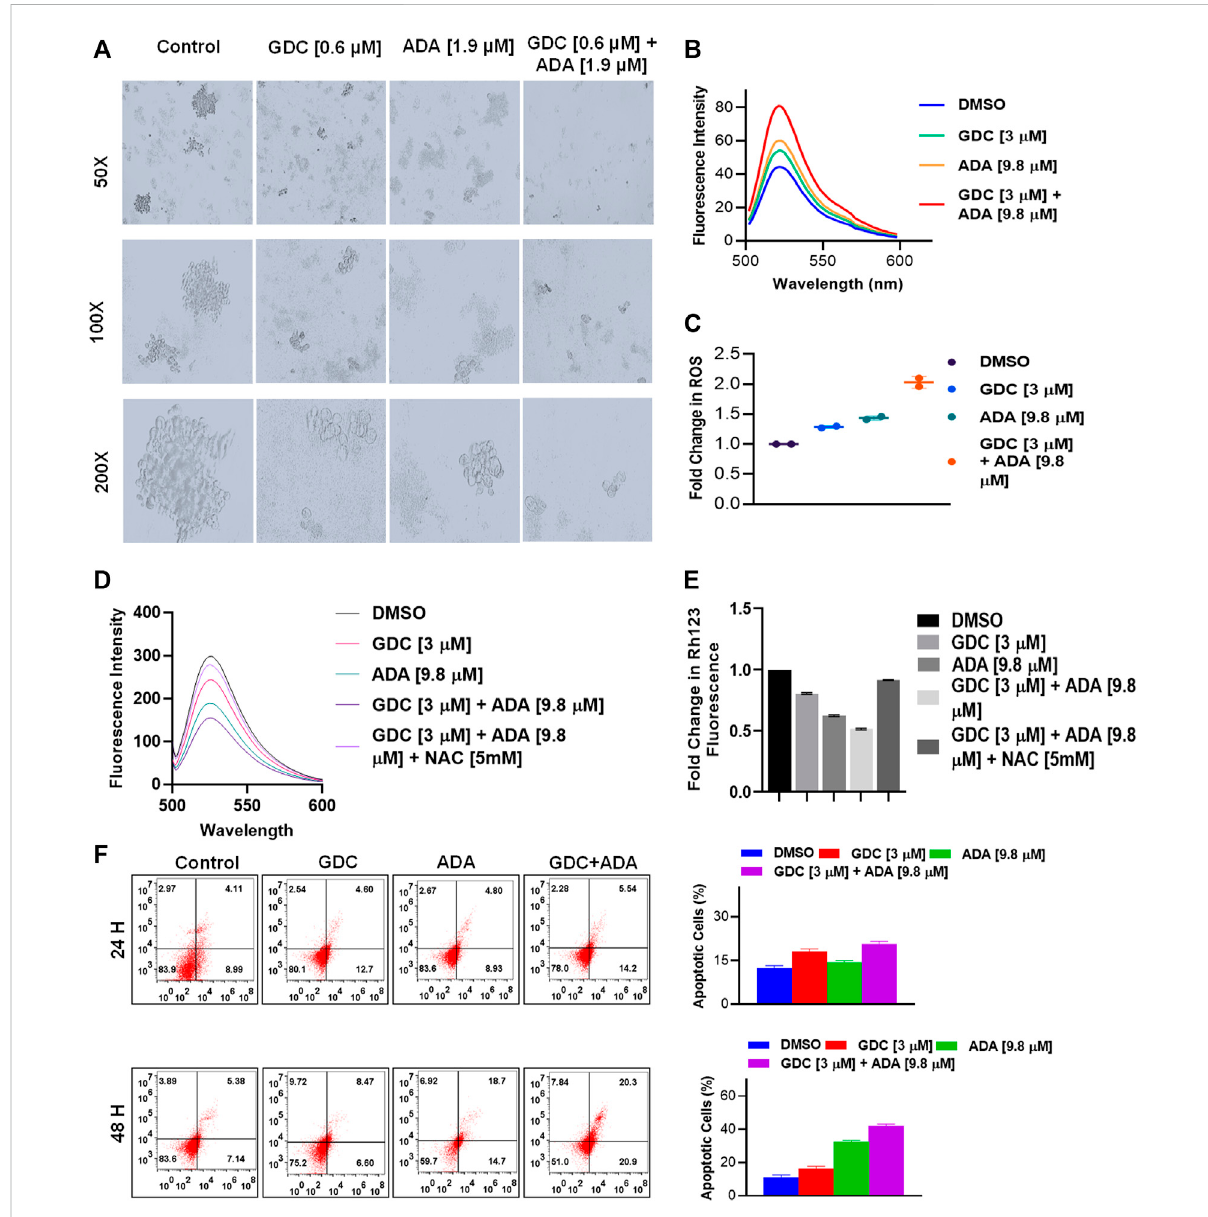
FIGURE 5 GDC-0941andadapaleneaffecttheanchorage-independentgrowthofMDA-MB-231cellsandenhanceapoptosis. (A) .Representativeimages of the spheroid assay. Treatment with the combination of GDC and ADA signi fi cantly reduced the growth of TNBC cells in ultra-low attachment plates. (B) . Fluorescence intensity and (C) . fold change in ROS levels in MDA-MB-231 cells treated with ADA (9.8 μ M) and GDC (3 μ M) alone or in combination for 24 hrs. (D) . fl uorescence intensity and (E) . fold change in Rh123 staining levels in MDA-MB-231 cells treated with ADA or GDC alone or in combination both showing decrease in mitochondrial membrane potential upon treatment. (F) . Annexin V & &-AAD staining showed increased apoptotic cells in plates treated with the combination of GDC and ADA after 24 h or 48 hr